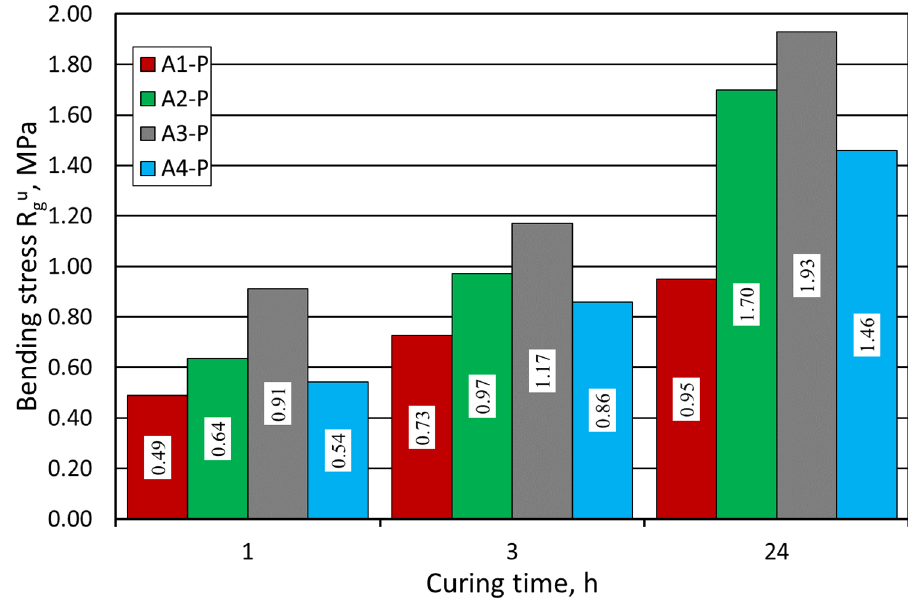
Figure 8. R u g bending stress test of the molding sand carried out on Pioma Foundry (P) grain matrix.